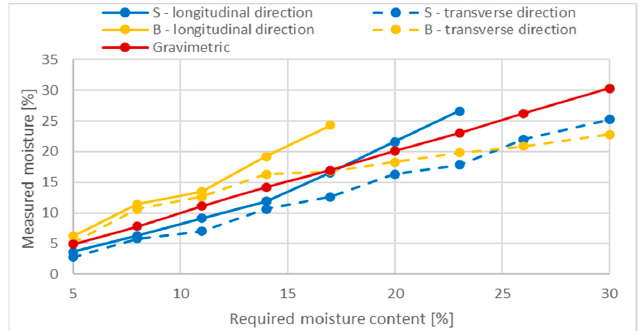
Figure 9. Dependence of the measured values of the GMI 15 moisture meter on the MC of different types of wood (S—spruce, B—beech) and in different directions in the moisture range of 5% to 30%.